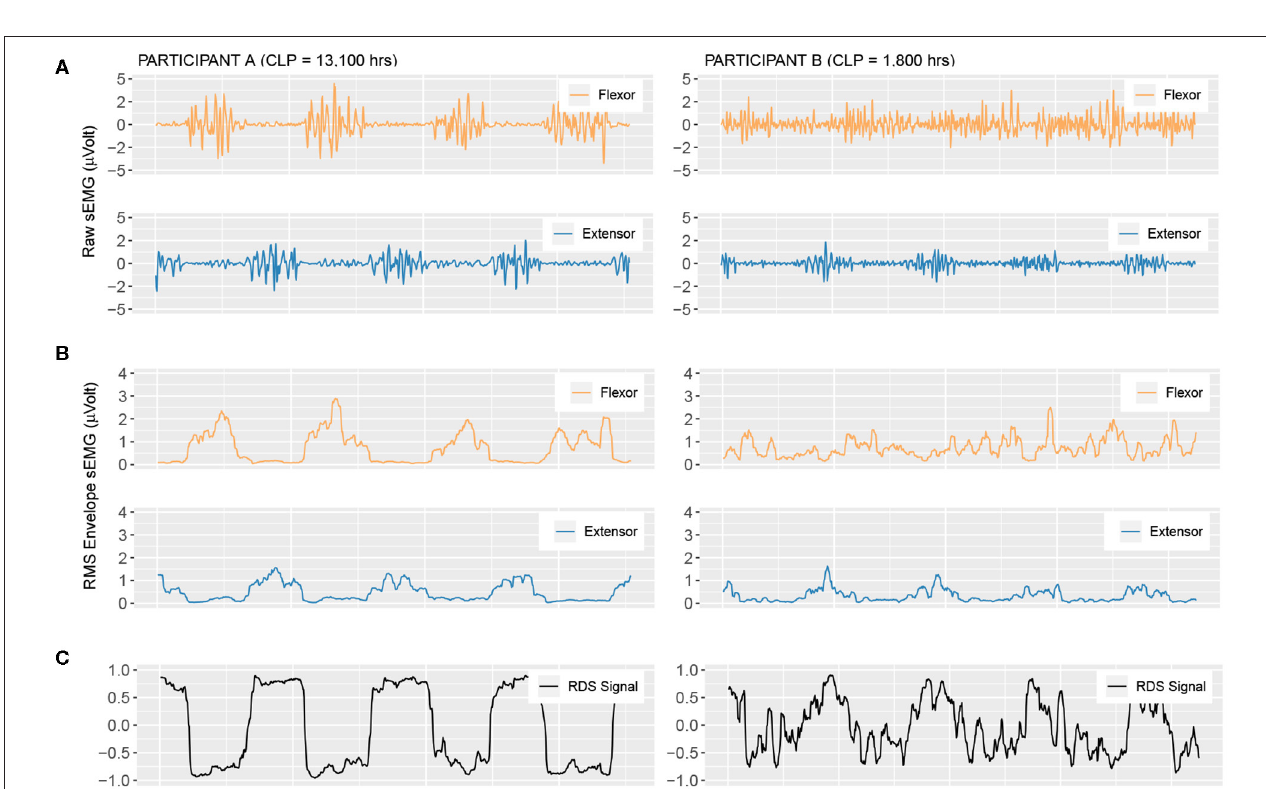
FIGURE 1 | Schematic of the positions of the infrared-reflective markers on the drum stick and drum pad. Three permanent markers at the drumstick allowed modeling a “virtual marker” at the tip of the drumstick (red sphere). Three permanent markers on the surface of the drum pad allowed for precise 6DOF tracking of the interaction between stick tip and drum pad surface.